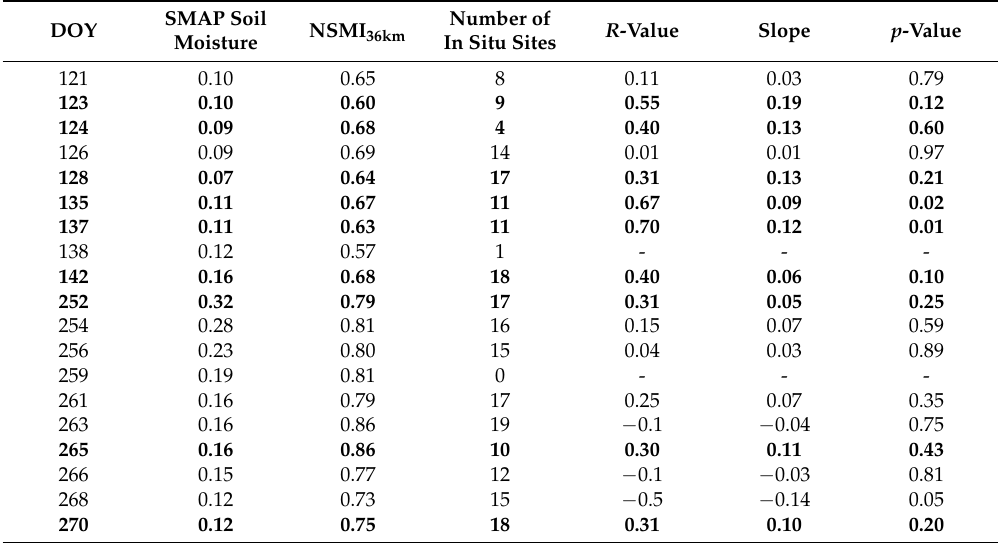
Table 3. Validation results regarding the NSMI. Relevant slope and p -values are reported in bold when R -value >